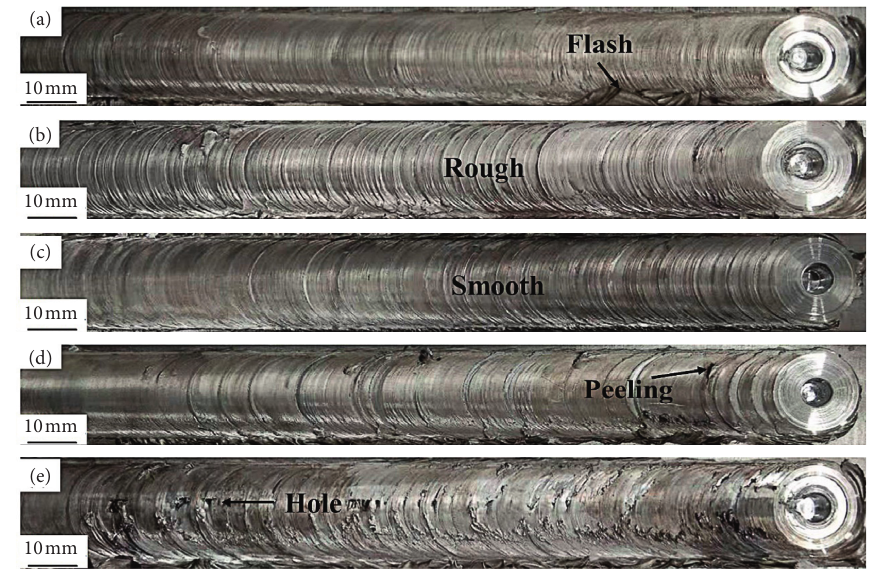
Figure 7: Macroscopic appearance of each sample under different welding parameters: (a) 15 mm/min; (b) 30 mm/min; (c) 50 mm/min; (d) 65 mm/min; (e) 80